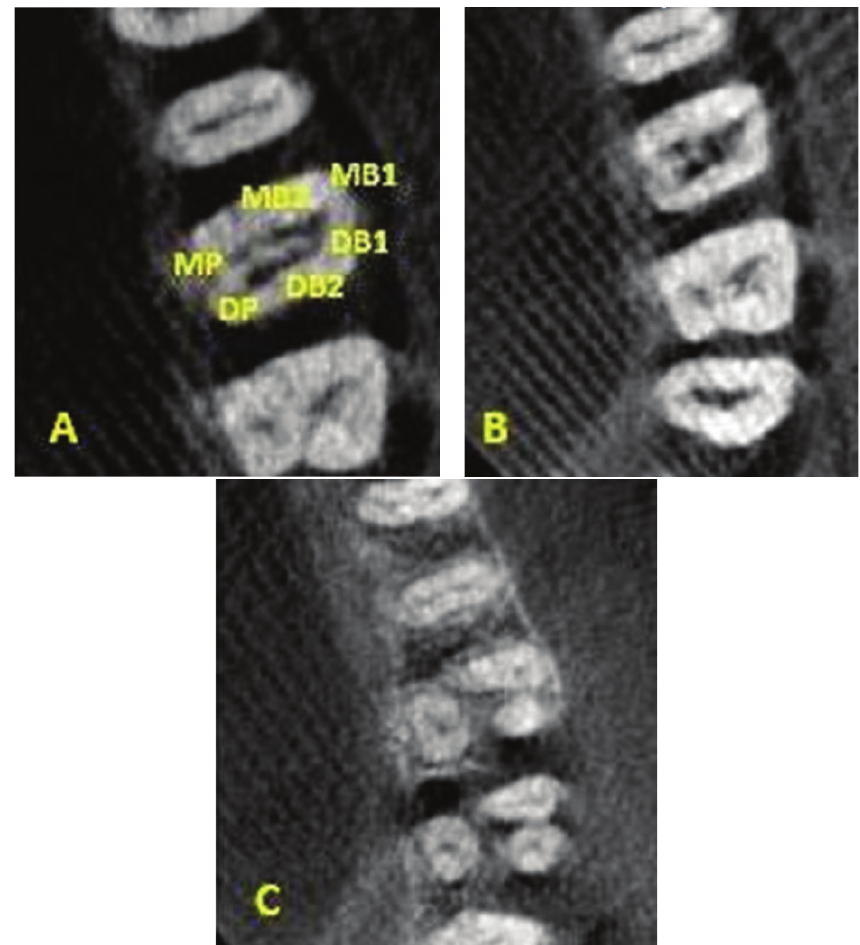
Figure 2: CBCT images showing 2 canals in each